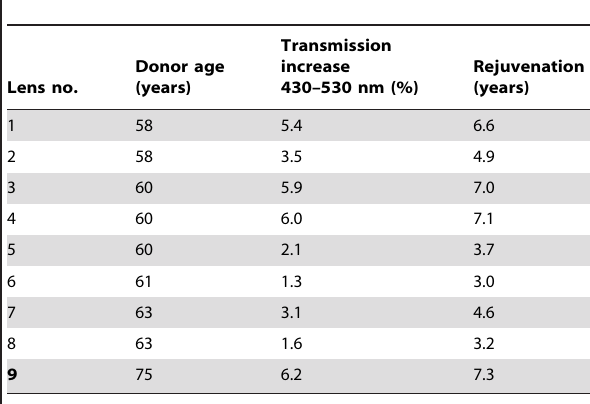
Table 1. Increase in transmission of human lenses after femtosecond laser photolysis.